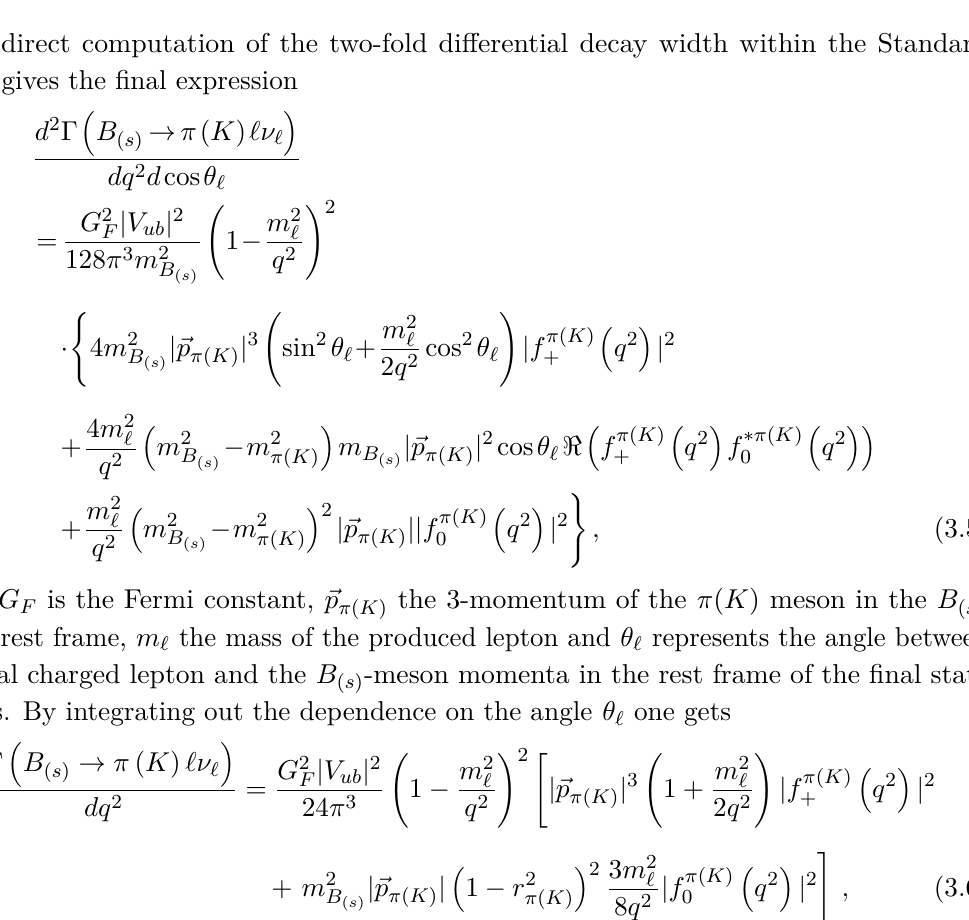
Table 1 . Mean values and uncertainties of the LQCD computations of the FFs f π at three selected values of q 2 from the results of the RBC/UKQCD [20] and FNAL/MILC [21] Collaborations. For the RBC/UKQCD computations the first error is statistical while the second one is systematic. The last column contains the results of the combination procedure given in eqs. (3.1)–(3.2) with ω ( k ) = 1 /N